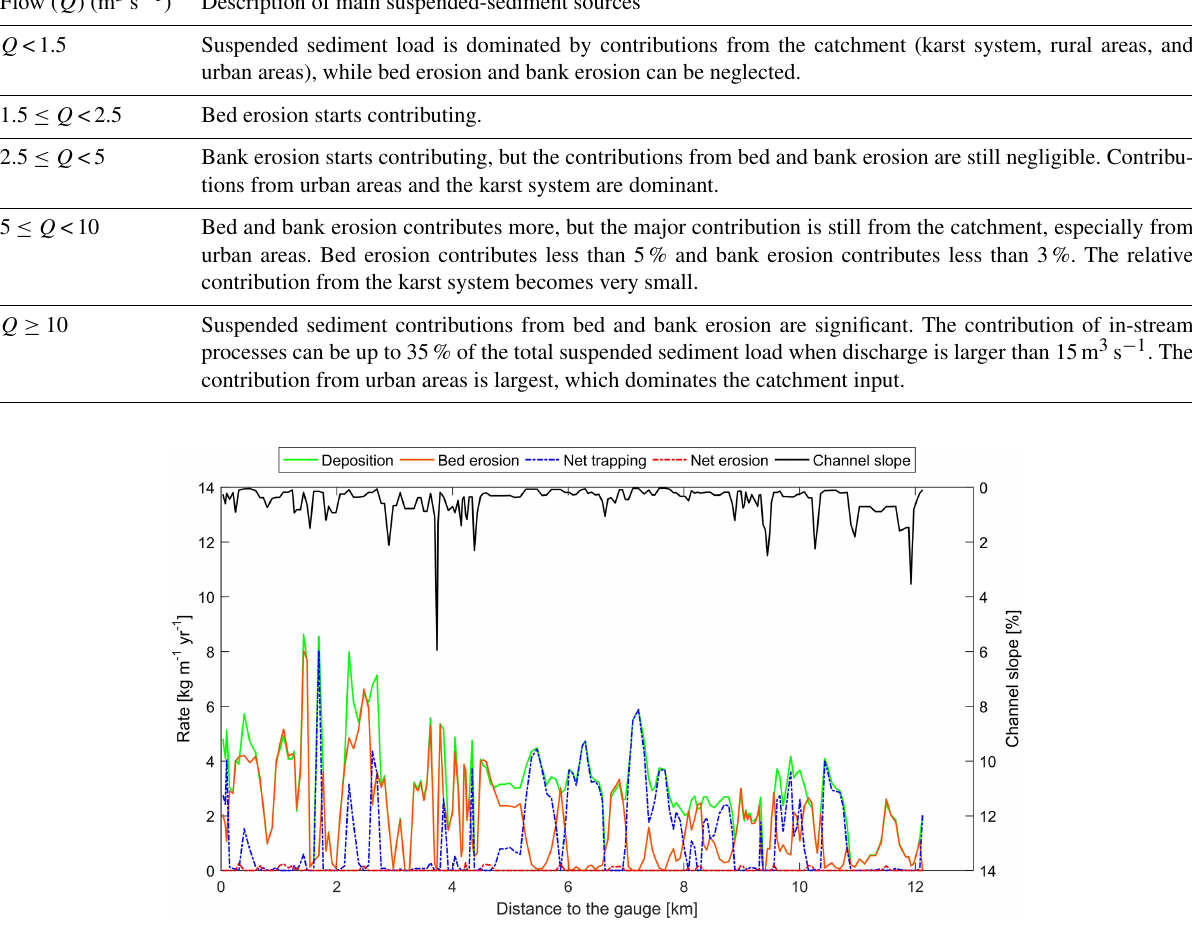
Figure 10. The distribution of the annual mean deposition, bed erosion, net sediment trapping, net sediment erosion, and channel slope along the main channel of the Ammer River (flow direction from right to left). The blue and red dash–dotted lines highlight net sediment trapping and net erosion,